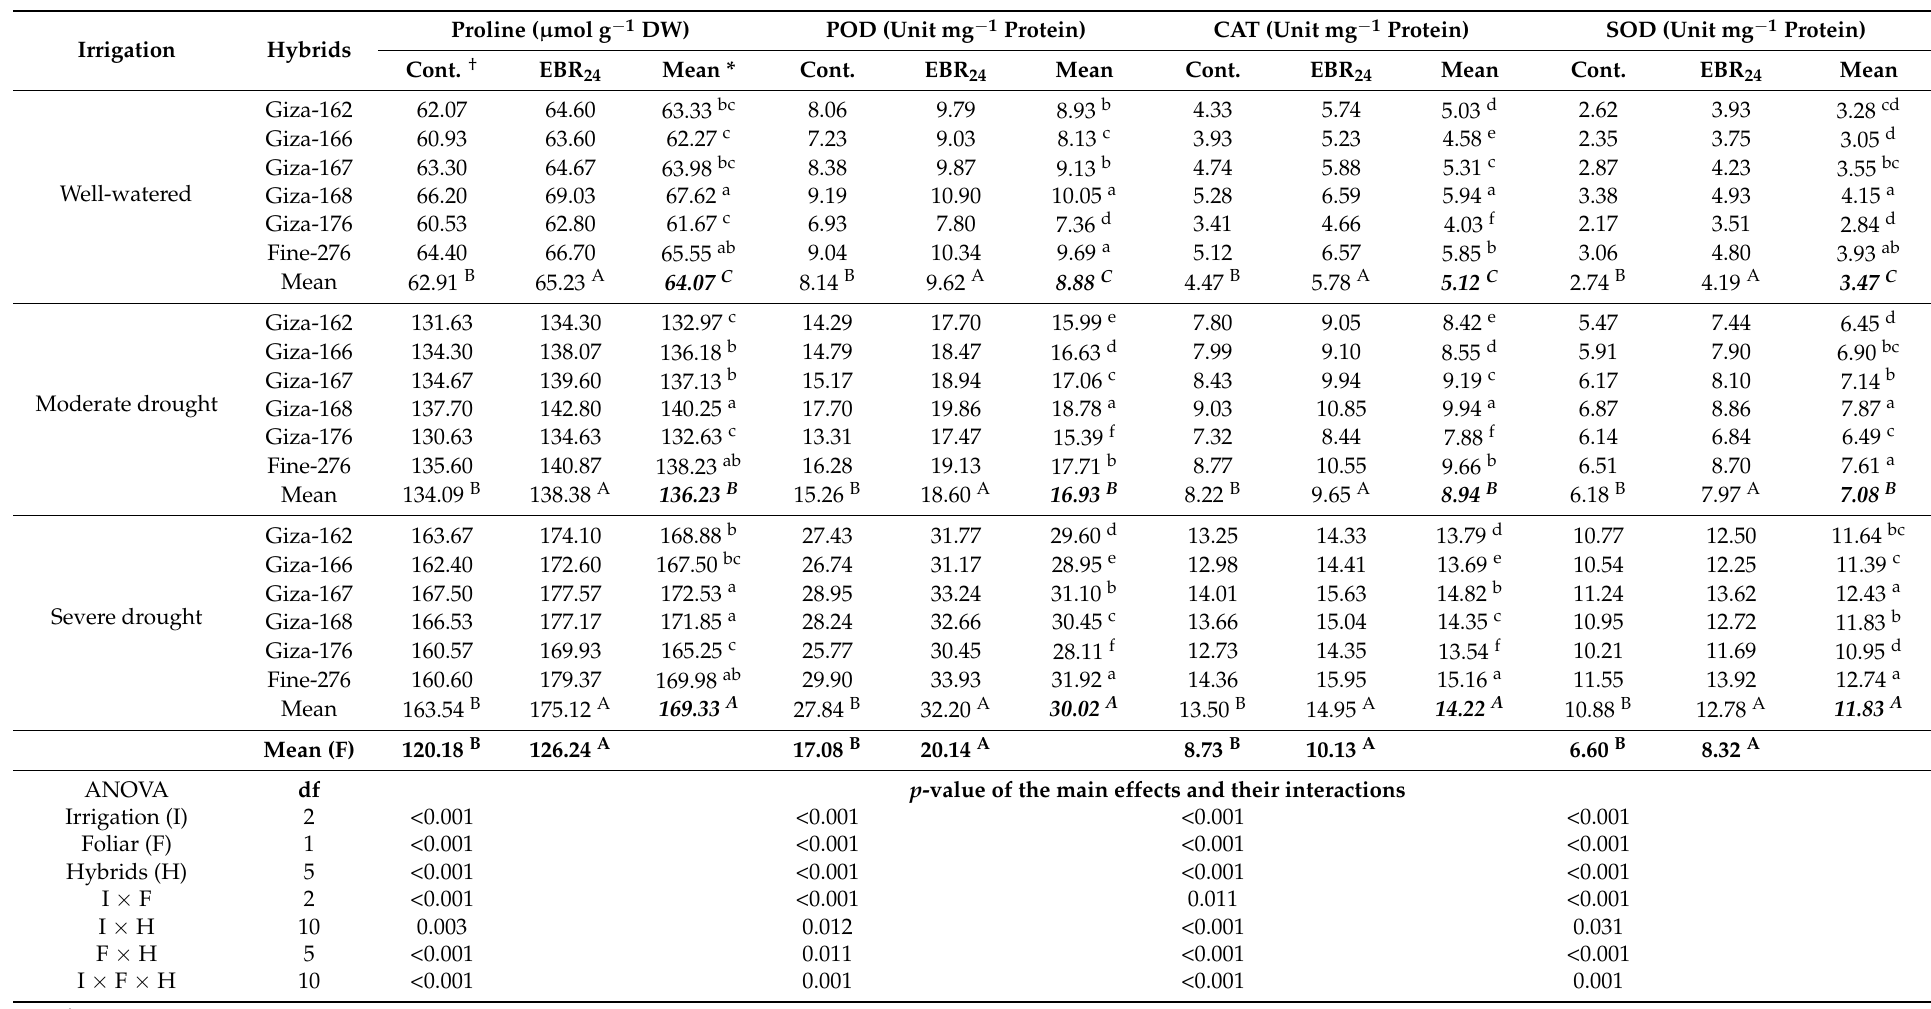
Table 5. Impact of 24-epibrassinolide (EBR 24 ) application on the proline content, peroxidase (POD), catalase activity (CAT), and superoxide dismutase activity (SOD) of six maize hybrids grown under three irrigation regimes over the two growing seasons of 2018 and 2019. Irrigation